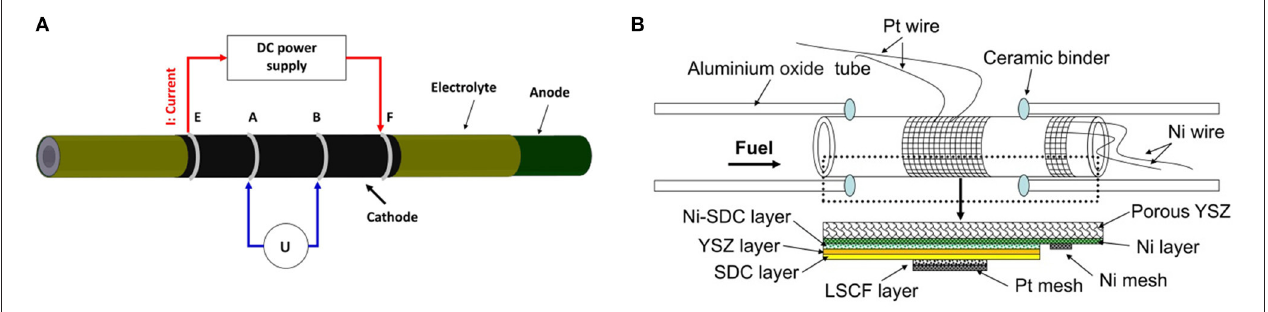
FIGURE 1 | (A) Schematic diagram of sheet resistance measurement setup, and (B) Schematic diagram of tubular single